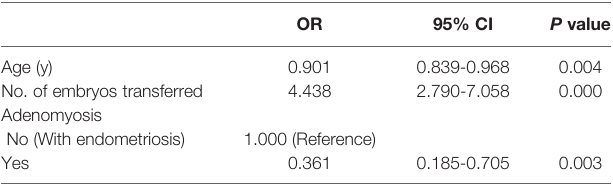
TABLE 4 | Factors associated with live birth rate by multivariate logistic regression analysis.